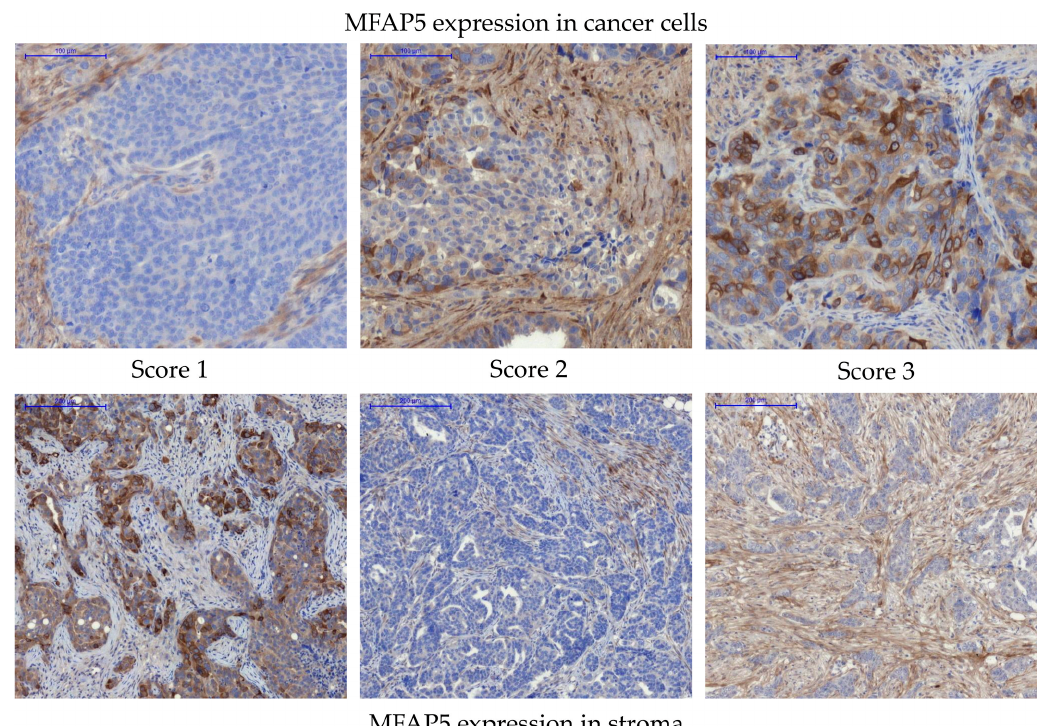
Figure 3. Immunohistochemical detection of MFAP5 in OC samples. Upper panel—representative examples of MFAP5 staining in cancer cells. Lower panel—representative examples of MFAP5 staining in the tumor stroma. The images show different levels of staining, from score 1 (weak expression), through score 2 (moderate expression), to score 3 (strong expression). Pannoramic 250 Flash II Scanner, scale bar: 100 µ m.